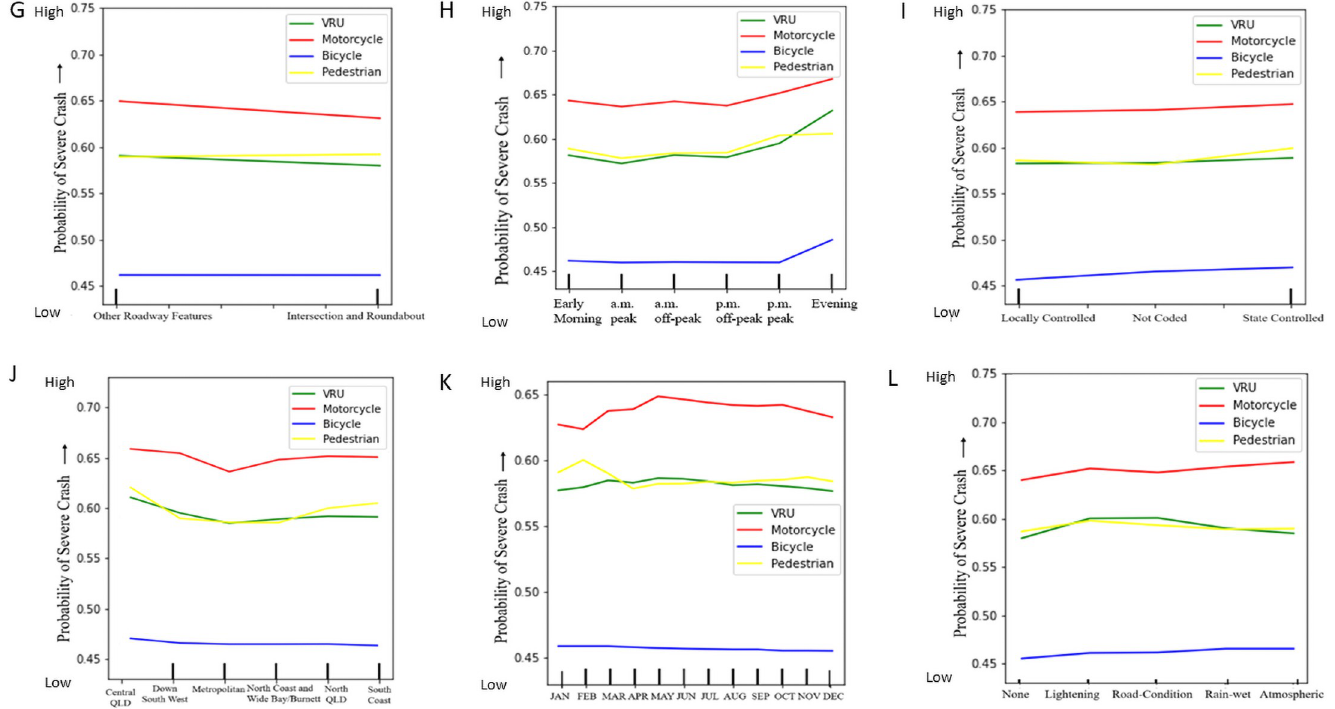
Fig 6. Partial dependency plots of different features with respect to VRU crash severity. (G) Roadway Features (H) Hour (Time of Day) (I) Road Section Authority (J) Road Region (K) Month (L) Road and Environment Condition.